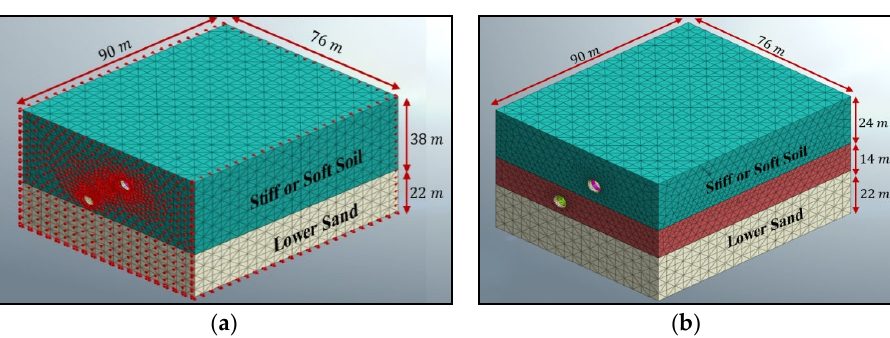
Figure 7. Angular offset tunnel dimensions.